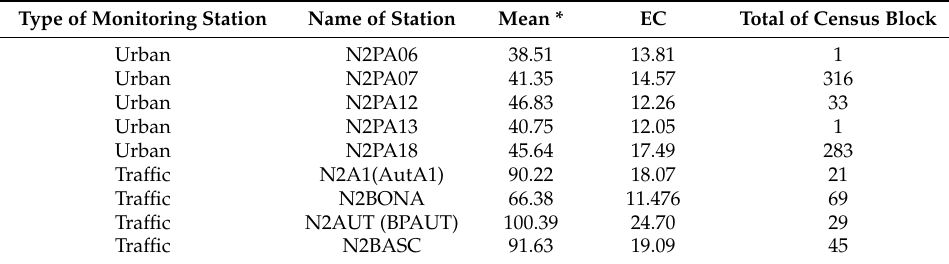
Figure 5. Dendogram of distances between all census blocks and monitoring stations. Table 2. Descriptive statistics of air quality monitoring stations in Paris.